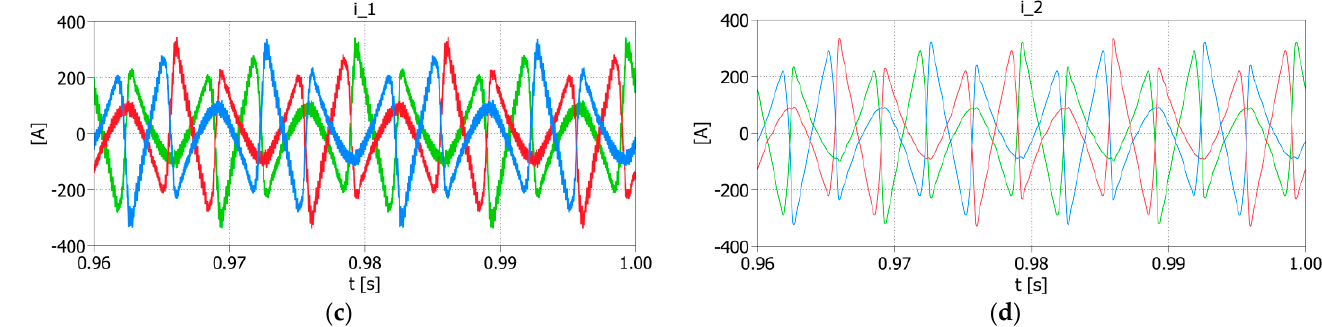
Figure 5. Harmonic compensation enabled: ( a ) voltage waveform in the PCC; THD u = 1.17%; ( b ) upstream current waveform in the PCC; THD i = 0.87%; ( c ) L 1 current waveform ( i 1 ); ( d ) L 2 current waveform ( i 2 = i k ).